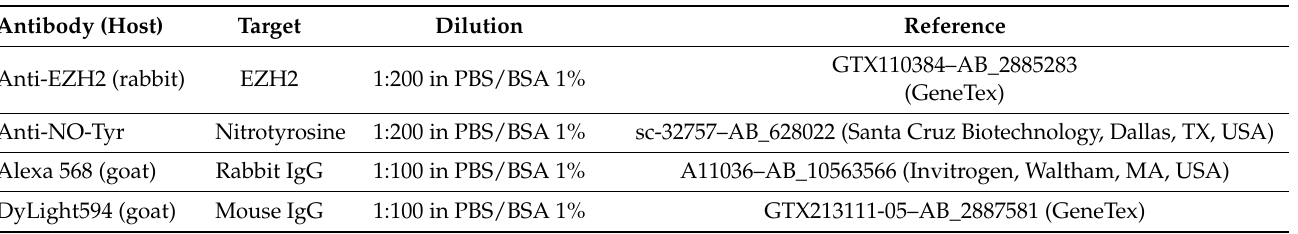
Table 2. List of antibodies used for STED immunolabelling. Antibodies name, host, target, dilution, and code are